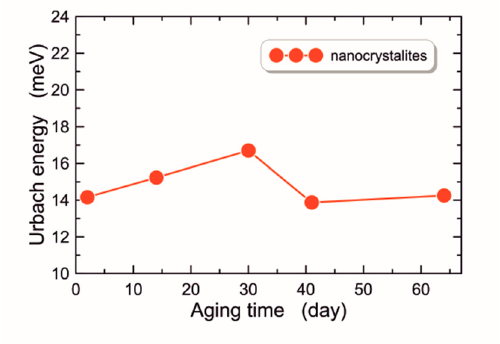
Figure 7. Urbach energy of the films formed in successive days of aging of the ZnO sol.